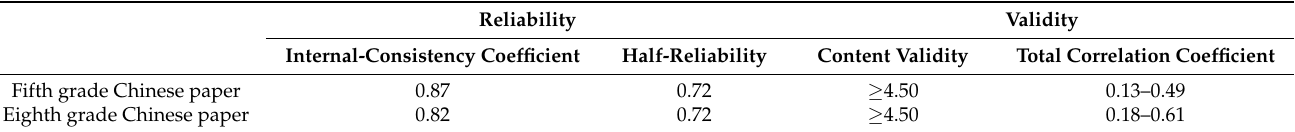
Table 2. Reliability and validity of academic test